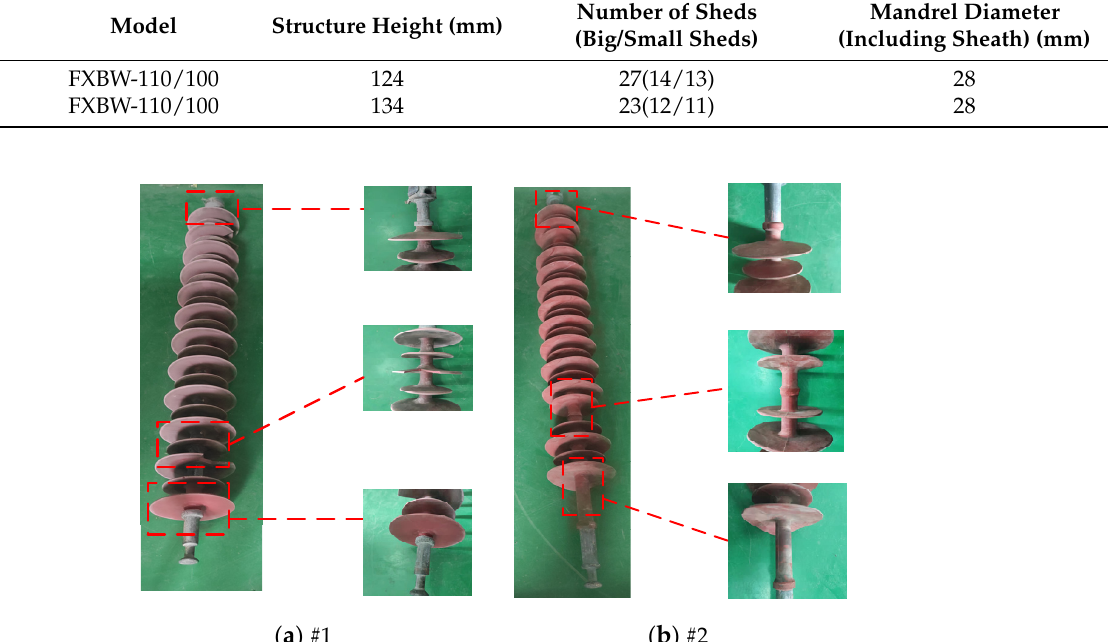
Figure 2. Appearance of abnormal heating composite insulator. ( a ) appearance of #1; and ( b ) ap- pearance of #2. Table 1. Parameters of samples.